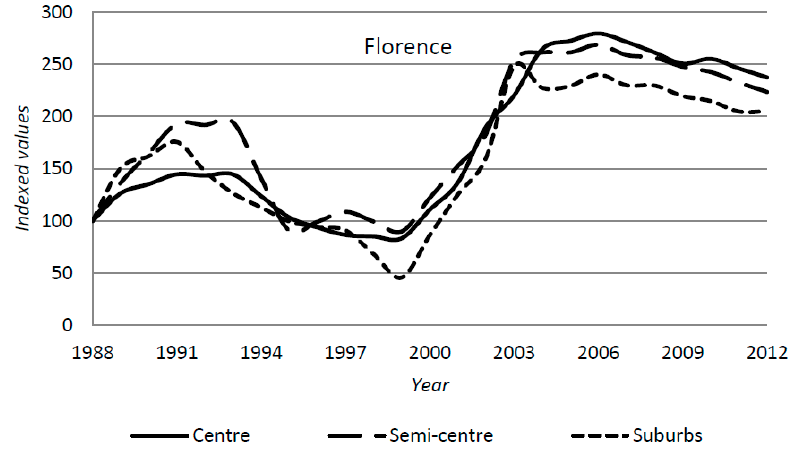
Figure 4. Trend of indexed urban land values from 1988 to 2012 in Florence.